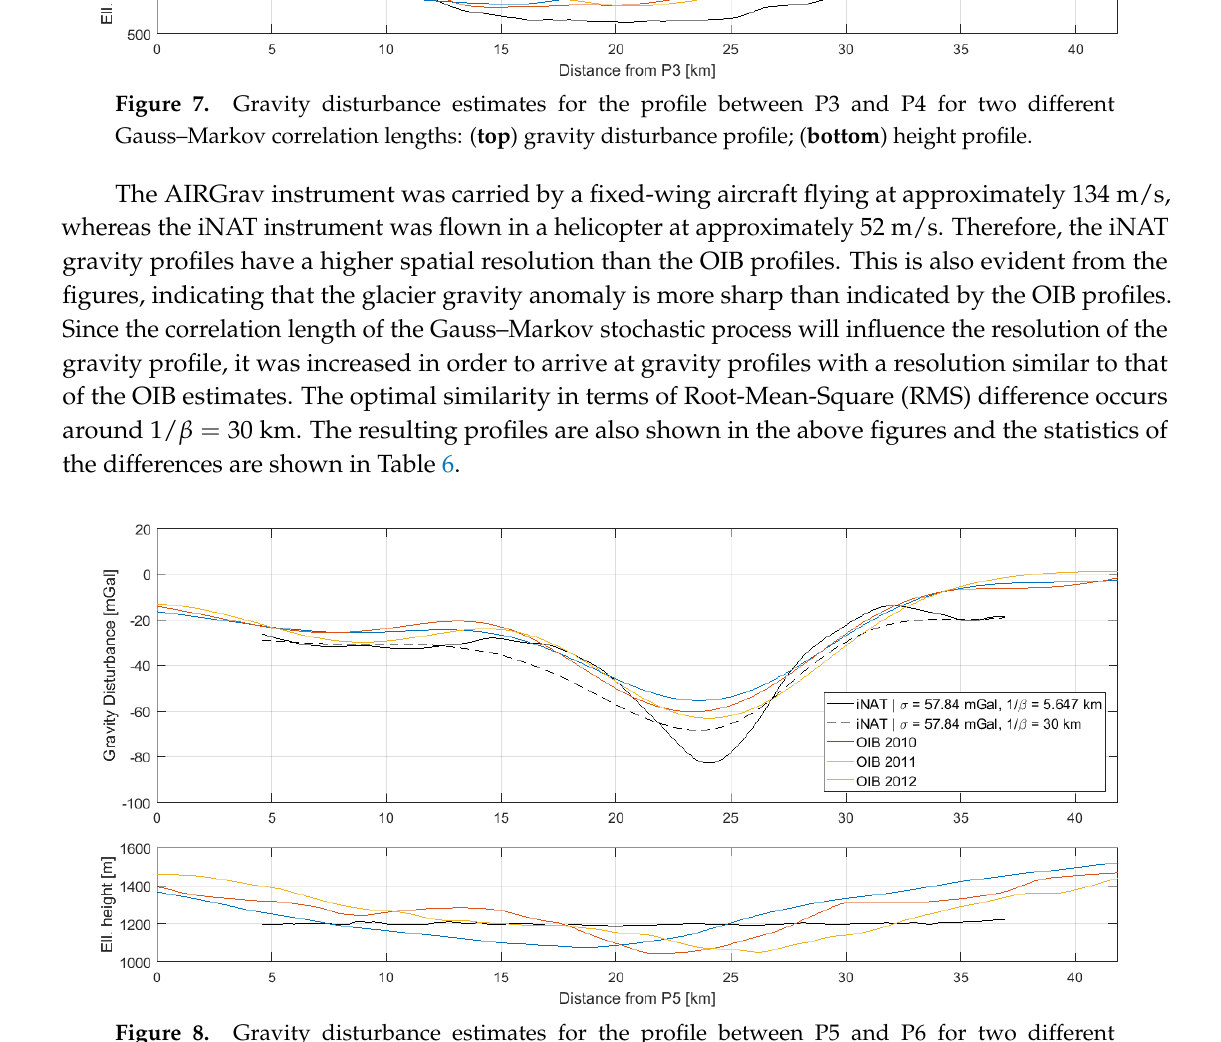
Figure 8. Gravity disturbance estimates for the profile between P5 and P6 for two different Gauss–Markov correlation lengths: ( top ) gravity disturbance profile; ( bottom ) height